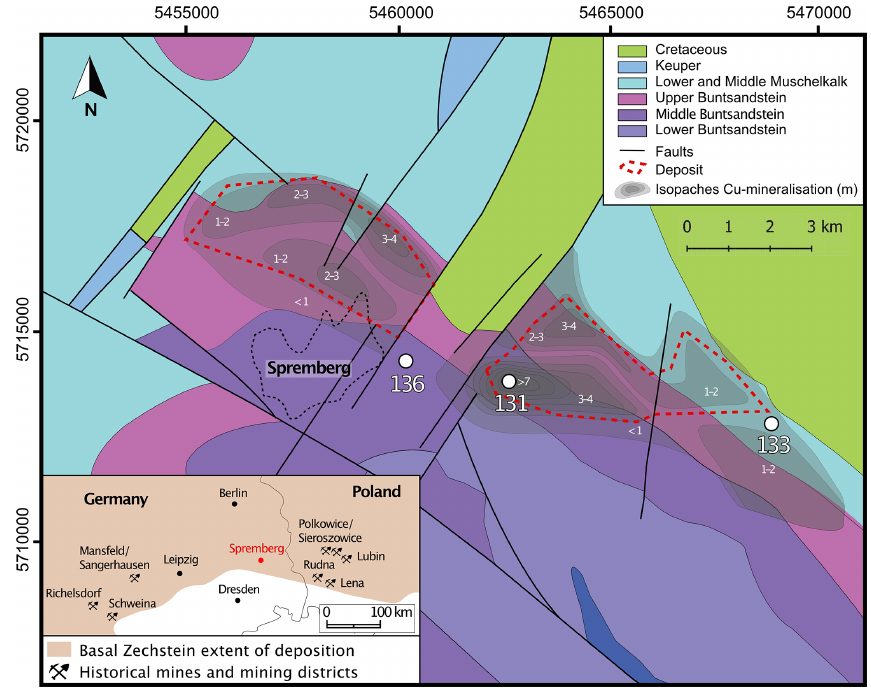
Figure 2. Geological map of the Spremberg–Graustein area showing the thickness of the economic Kupferschiefer-type mineralisation (after Kopp et al., 2006) and the location of the three drill holes that were the subject of this study. Coordinate system: RD/83 Gauss–Krüger zone 5. Table 1. Acquisition parameters of the SisuROCK drill core